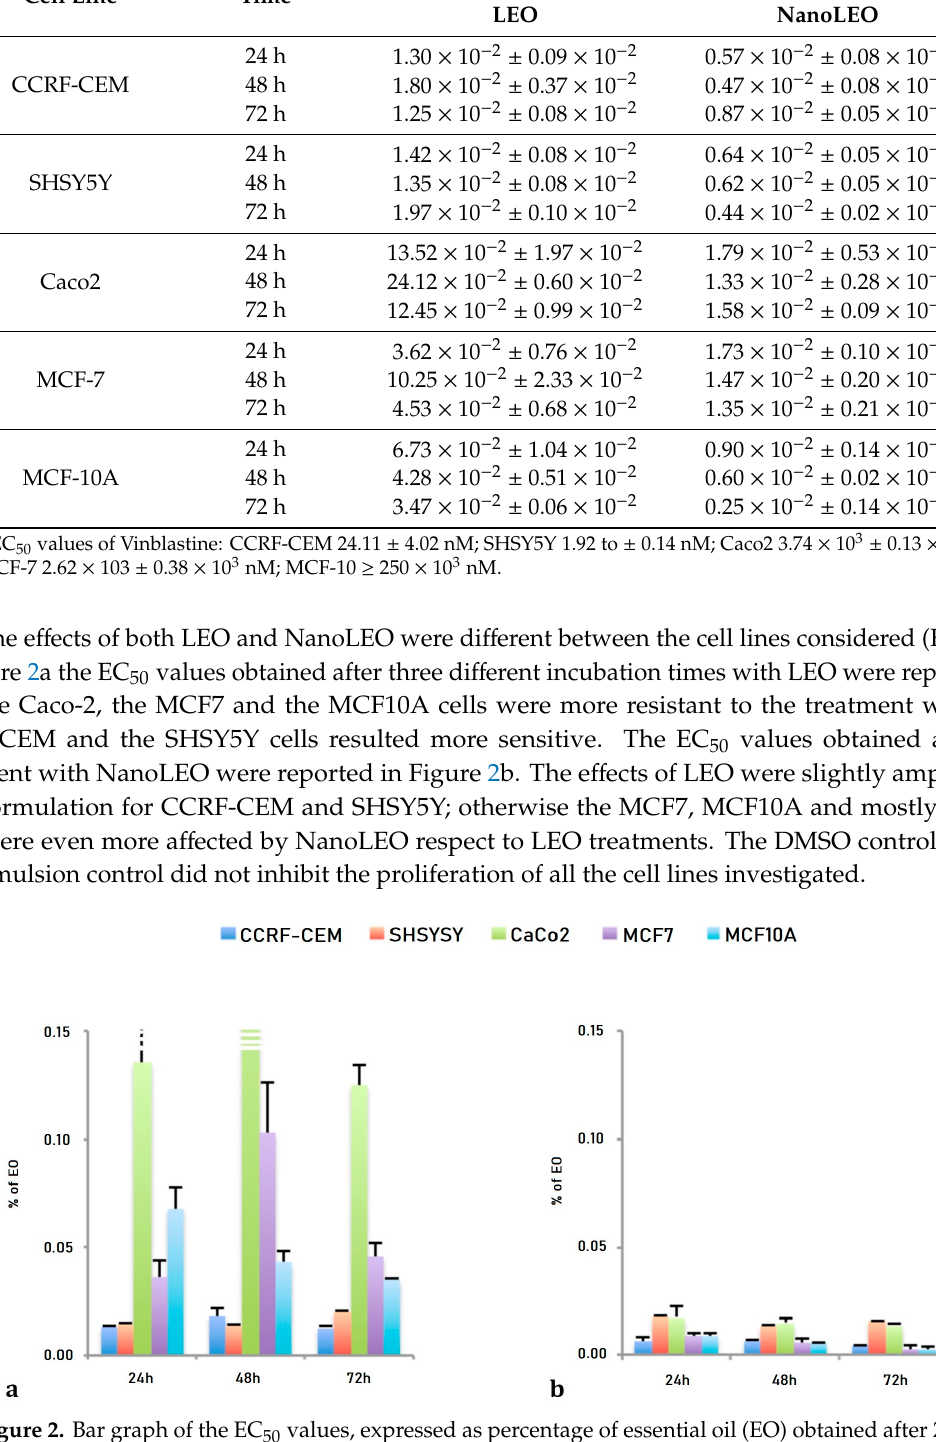
Figure 2. Bar graph of the EC 50 values, expressed as percentage of essential oil (EO) obtained after 24 h, 48 h and 72 h of treatment. ( a ) lavandin essential oil (LEO) and ( b ) nanoemulsion of lavandin essential oil (NanoLEO). p < 0.05 according to ANOVA test.